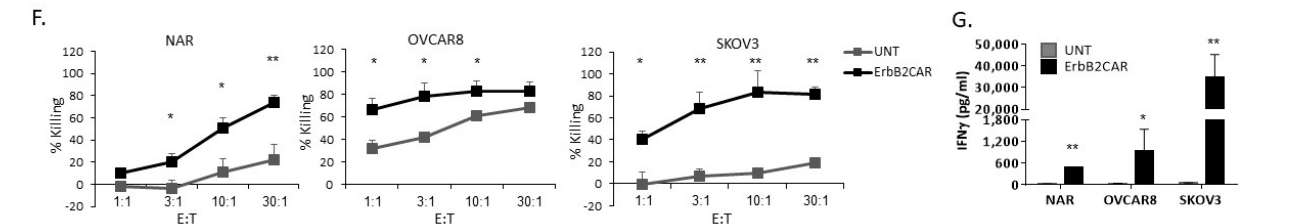
Figure 1. Characterization and in vitro activity of ErbB2CAR-T cells : ( A ) The ErbB2CAR construct is comprises the ScFv specifically directed against ErbB2 followed by the co-stimulation domain of CD28 and the activation domain from Fc γ R. ( B , C ): Retroviral supernatant collected from ErbB2-expressing packaging cells (PG13) was used to infect PBLs from a healthy donor. Infected and non-infected cell cultures were grown for an additional 3 days following transduction. On the day they were harvested, the cells were analyzed by flow cytometry and the CAR expression level was calculated. ( B ) A representative flow cytometry analysis of lymphocytes transduced with ErbB2CAR-GFP. ( C ) Average transduction expression of the ErbB2CAR-GFP. The dots indicate four independent experiments, and the lines show mean ± STDEV. ( D ) Expression of CD4/CD8 gated from CD3 positive cells out of ErbB2CAR-GFP transduced T cells. Transductions of four donors are shown; a line indicates the average. ( E ) Expression of ErbB2 antigen on the human OC cell lines NAR, OVCAR8, and SKOV3. Cells were stained with anti-human ErbB2-APC or mouse IgG1k-APC isotype control and analyzed by flow cytometry. ( F ) Killing assay using effector (E) and target cells (T). Cells were incubated for 16 h with ErbB2CAR or UNT T cells (as control) at different E:T ratios as indicated. The percentage of killing was measured by methylene blue colorimetric assay. An average of five ErbB2CAR versus UNT experiments are presented with ± SEM. * p < 0.05; ** p < 0.01. ( G ) T cells transduced with ErbB2CAR (black bars) or UNT cells (gray bars) were co-cultured with the indicated ovarian cell lines at an E:T ratio of 2:1. After 16 h, IFN γ levels in culture supernatants were measured by ELISA. The results shown are the average of three experiments ± STDEV. ErbB2CAR versus UNT * p < 0.05; ** p < 0.01. F/G statistical analysis was performed using Student’s t -test between ErbB2CAR versus UNT treatment.